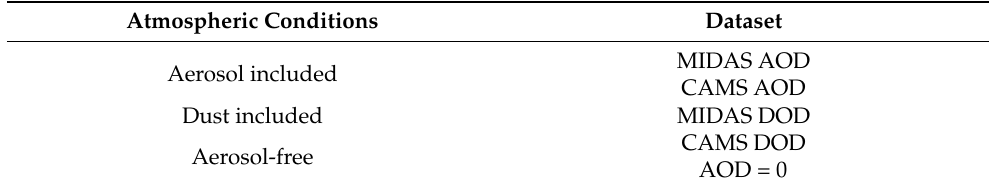
Table 2. The different experiments for which DSSI values were extracted from the fine LUTs.